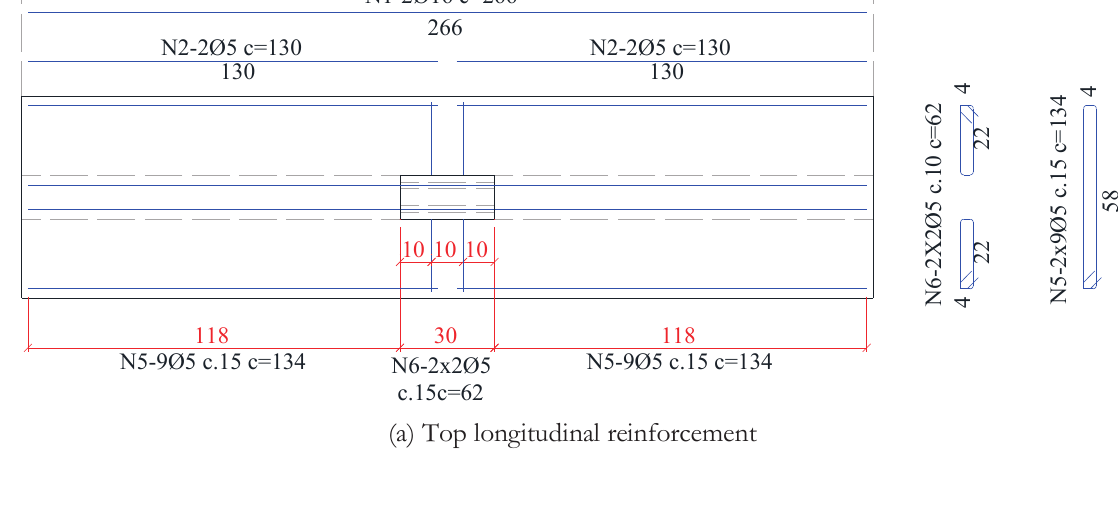
(a) Top longitudinal reinforcement